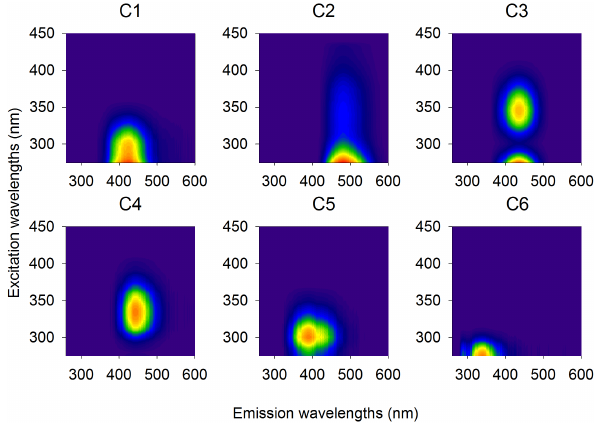
Figure 4. Fluorescence signatures of the components identified by the PARAFAC model. Fluorescence peaks are observed at the fol- lowing wavelengths (nm), for excitation and emission, respectively (secondary peak in parentheses): C1: 275, 424; C2: 275(340), 484; C3: 275(345), 436; C4: 334, 446; C5: 300, 388; C6: 275,